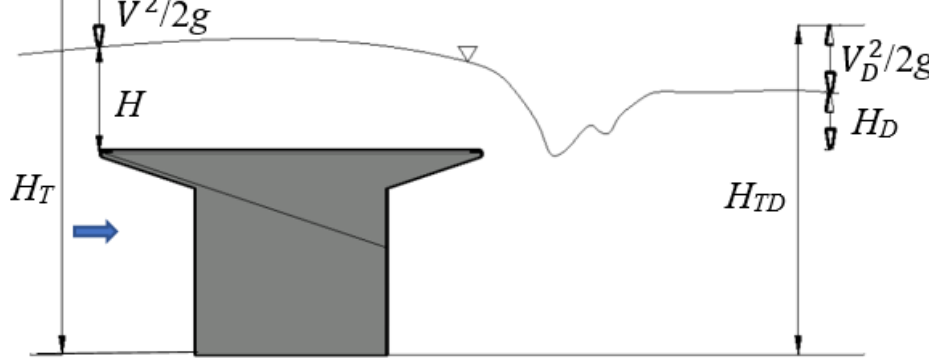
Figure 5. PK weir under submerged condition, where V and V D are the upstream and downstream velocity of the PK weir.